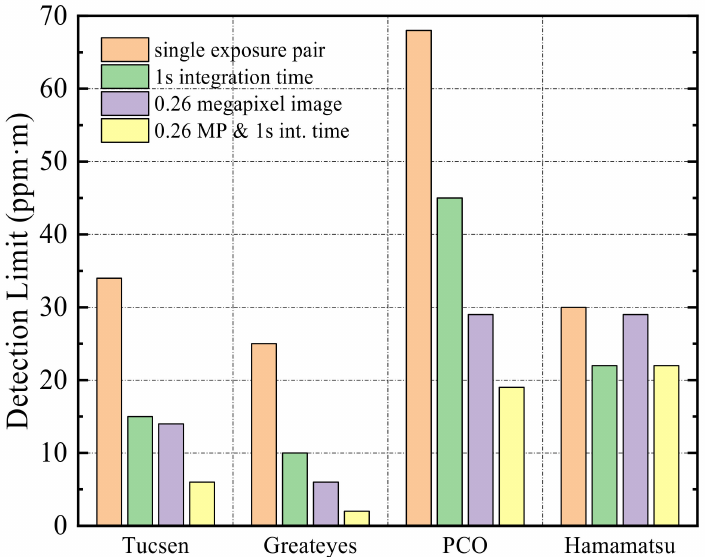
Figure 14. Detection limits of different camera systems with a detection distance of 2 km and atmospheric visibility of 20 km.